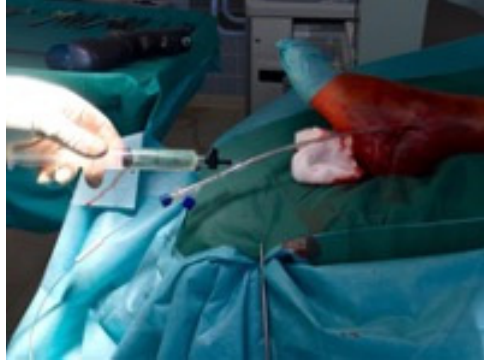
Figure 5. This figure shows the infusion of the balloon with the monomer.